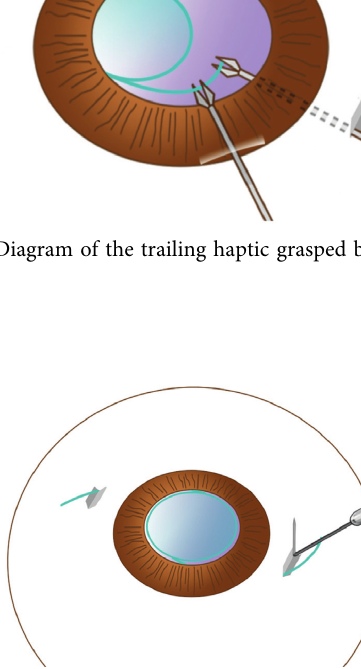
Figure 4: Diagram of the tunnel made by a bent 29G × 1/2 ″